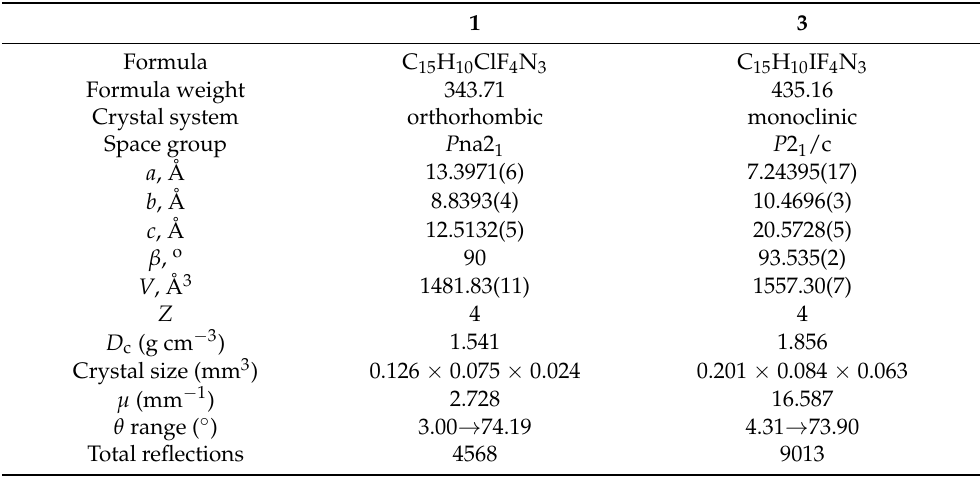
Table 1. Crystallographic data for 1 ‐ (2,3,5,6 ‐ tetrafluoropyridyl) ‐ 3 ‐ benzylimidazolium chloride ( 1 ) and iodide ( 3 ) 1 .